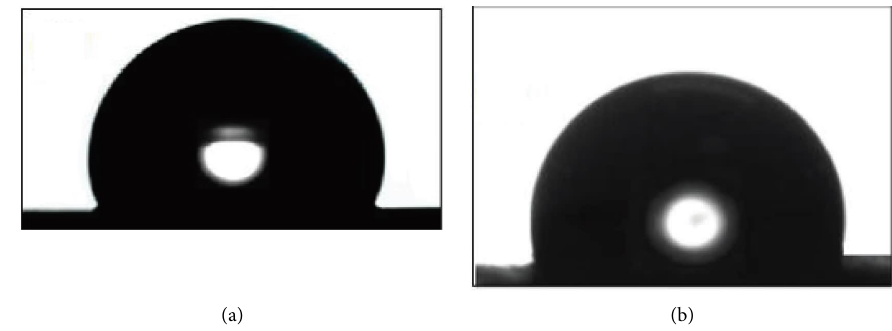
Figure 7: CAs of a water droplet on (a) AU-MNPs and (b) AP-MNPs